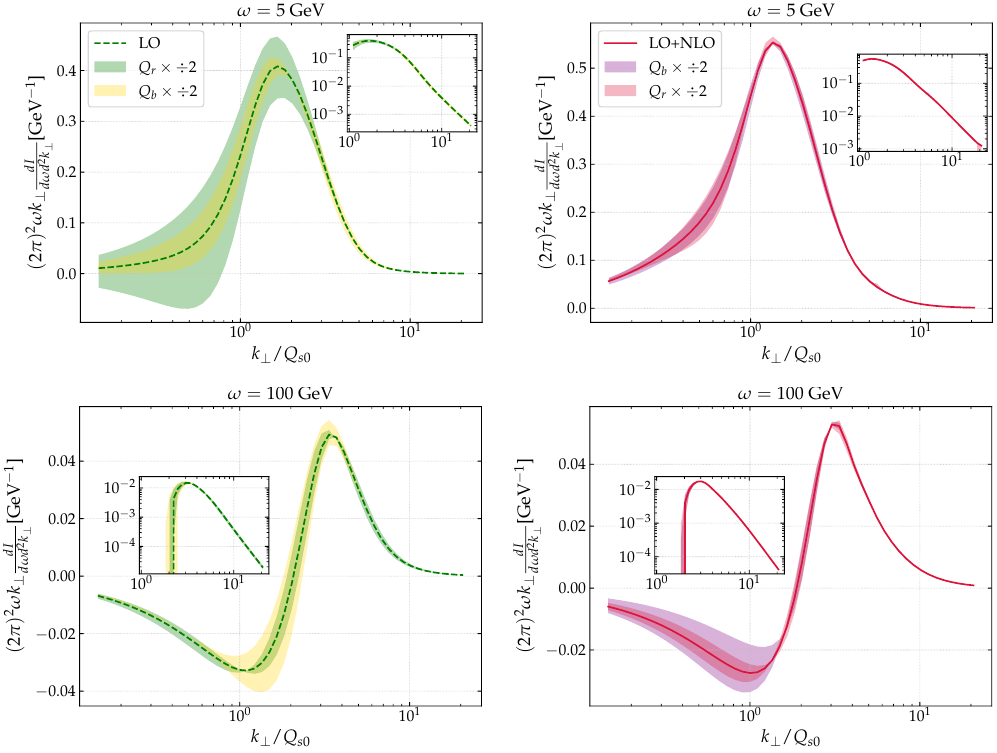
Figure 3 . Impact of variations by a factor of 2 in the two matching scales, Q b and Q r , on the LO (left column) and the LO+NLO (right column) at two different frequencies: ω =5 , 100 GeV on the top and bottom rows,